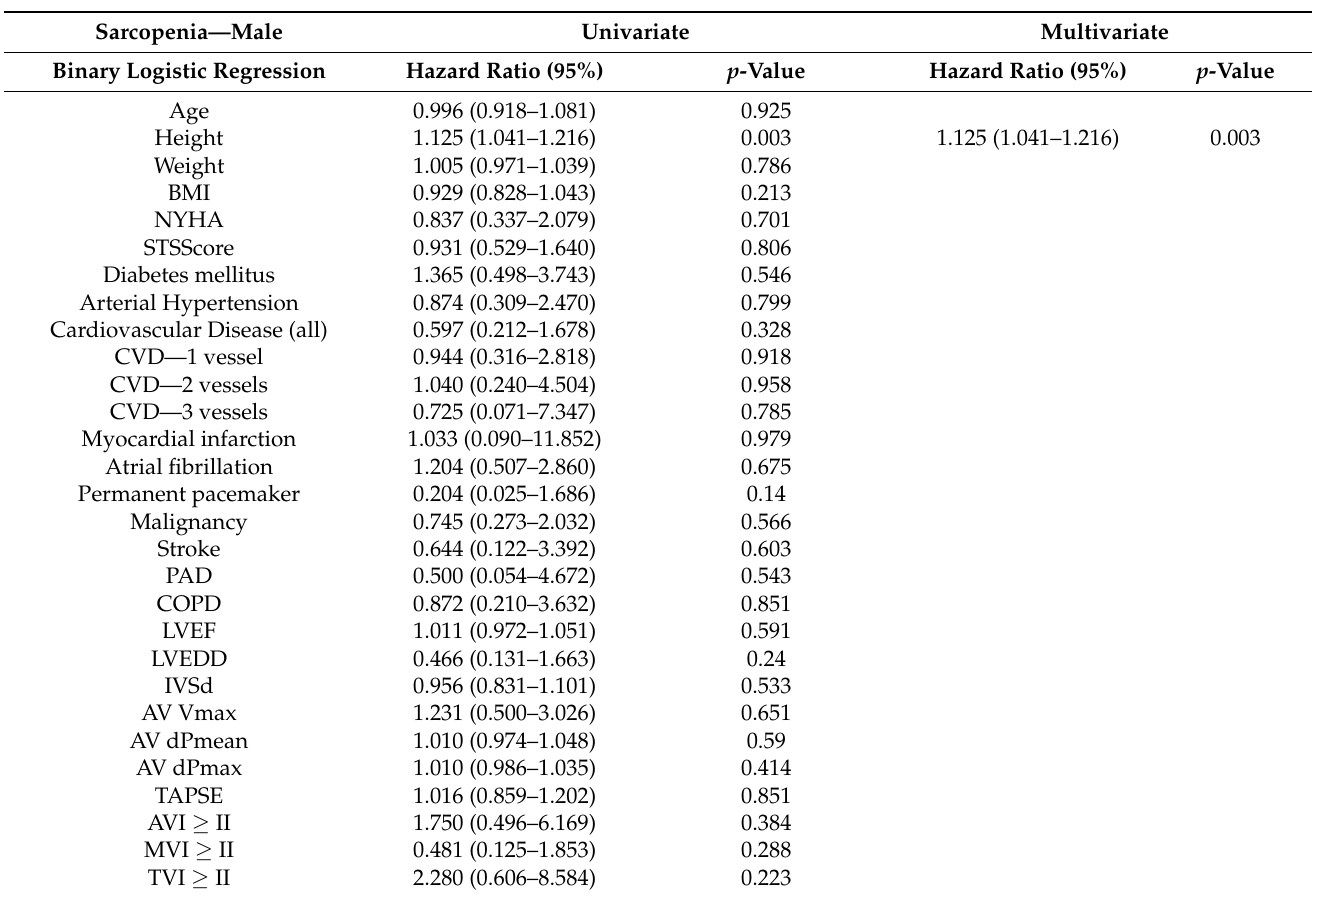
Table 4. Univariate and multivariate binary logistic regression analysis of male patients for the detection of predictors of